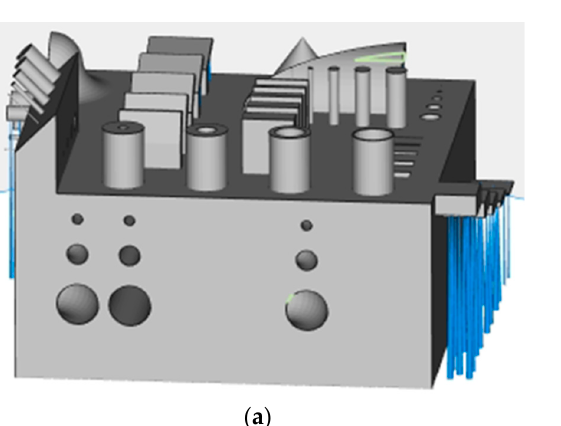
Figure 1. Steel build plate 100 mm in diameter with ( a ) density cubes 10 × 15 × 10 mm³ and vertical